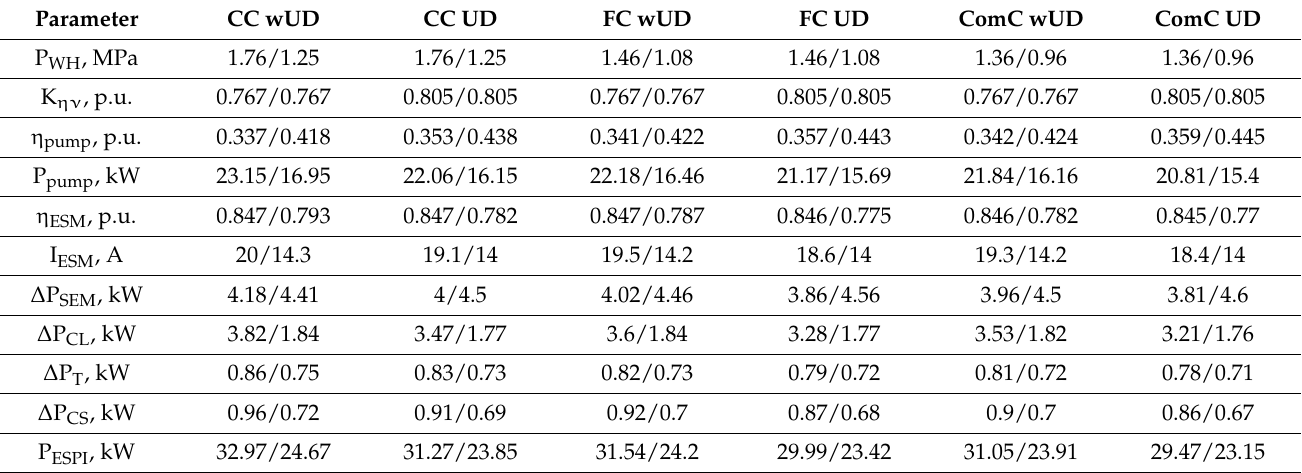
Table 5. Energy parameters of the equipment operation.